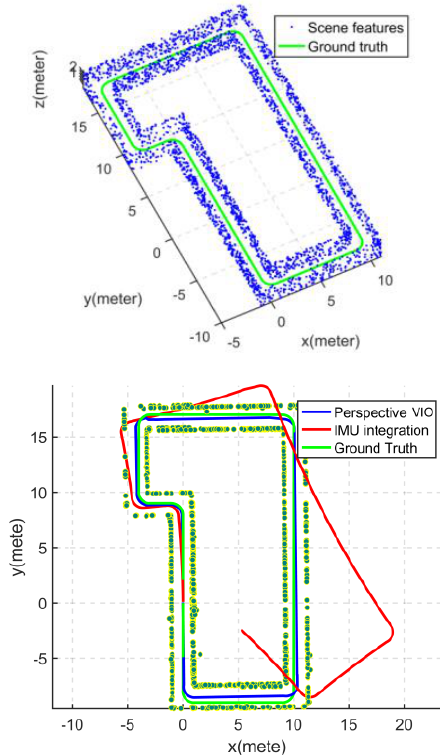
Figure 3. Top : The simulated indoor environment with the generated feature points. Bottom : The top view of the simulated indoor environment and the estimated trajectory (blue) compared with the IMU trajectory (red) and the ground truth